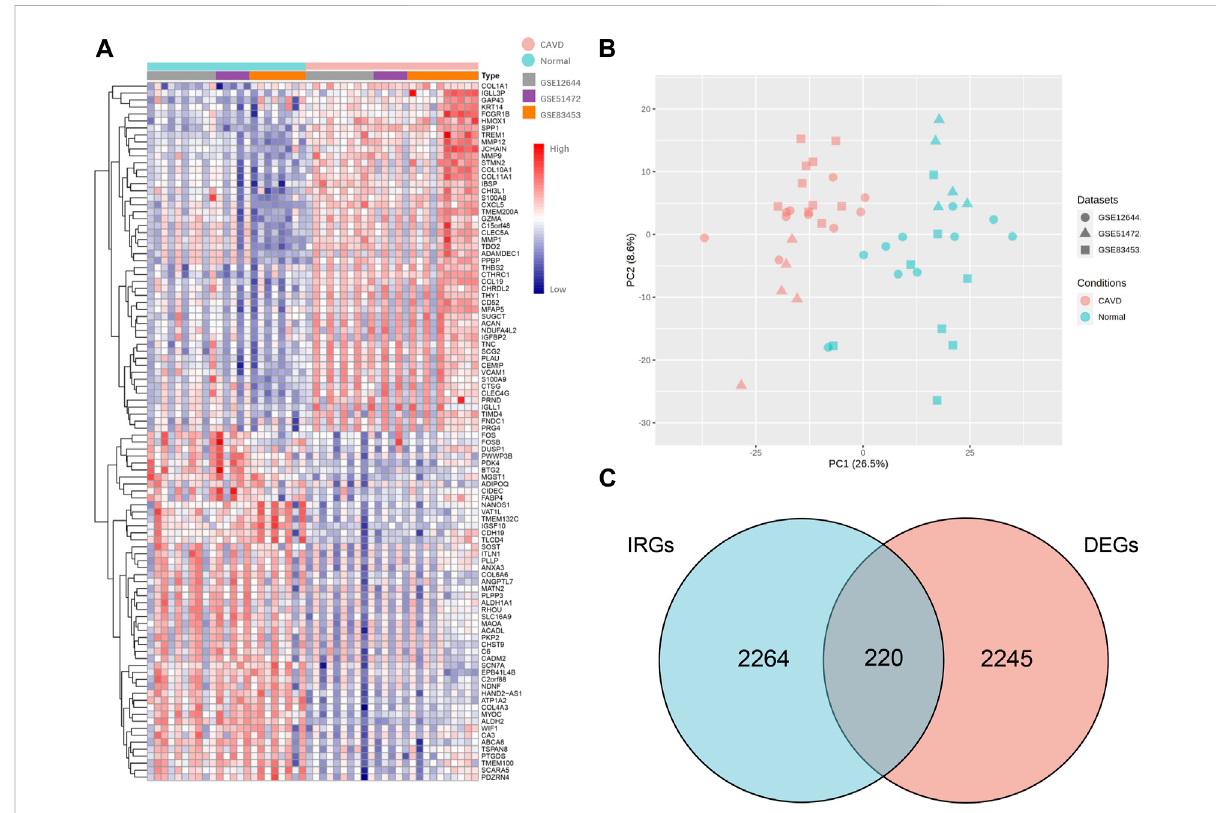
FIGURE 2 Identi fi cation of DEIRGs between aortic valve samples from patients with CAVD and normal individuals through network-based meta-analysis. (A) Heatmap of top 50 up-regulated DEIRGs and top 50 down regulated DEIRGs across different datasets (according to fold changes), hierarchal clustering isappliedbased on complete linkage method. (B) PCA plot after removingbatch effect between GSE12644, GSE51472 and GSE83453. (C) VennplotofscreeningDEIRGsbymatchingthe2,484IRGsfromImmPortdatabasetothe2,465DEGs.CAVD,calci fi caorticvalvedisease;IRGs, immune related genes; DEGs, differentially expressed genes; DEIRGs, differentially expressed immune related